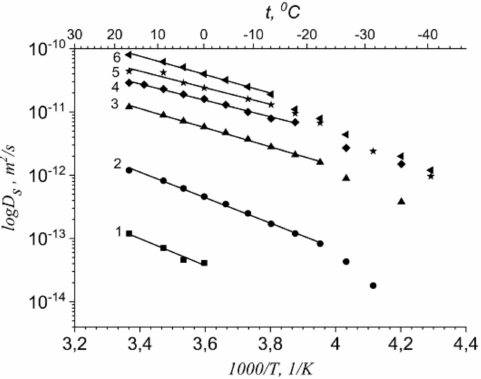
Figure 35. Li + cation self-diffusion coefficient temperature dependences for Nafion membrane Li + ionic form at different water content λ , where λ is water amount per sulfonate group. (1) λ = 0.9, (2) λ = 2.0, (3) λ = 4.0, (4) λ = 5.7, (5) λ = 7.4, (6) λ = 10.7. Reprinted with permission from [109]. Copyright 2021 Elsevier.